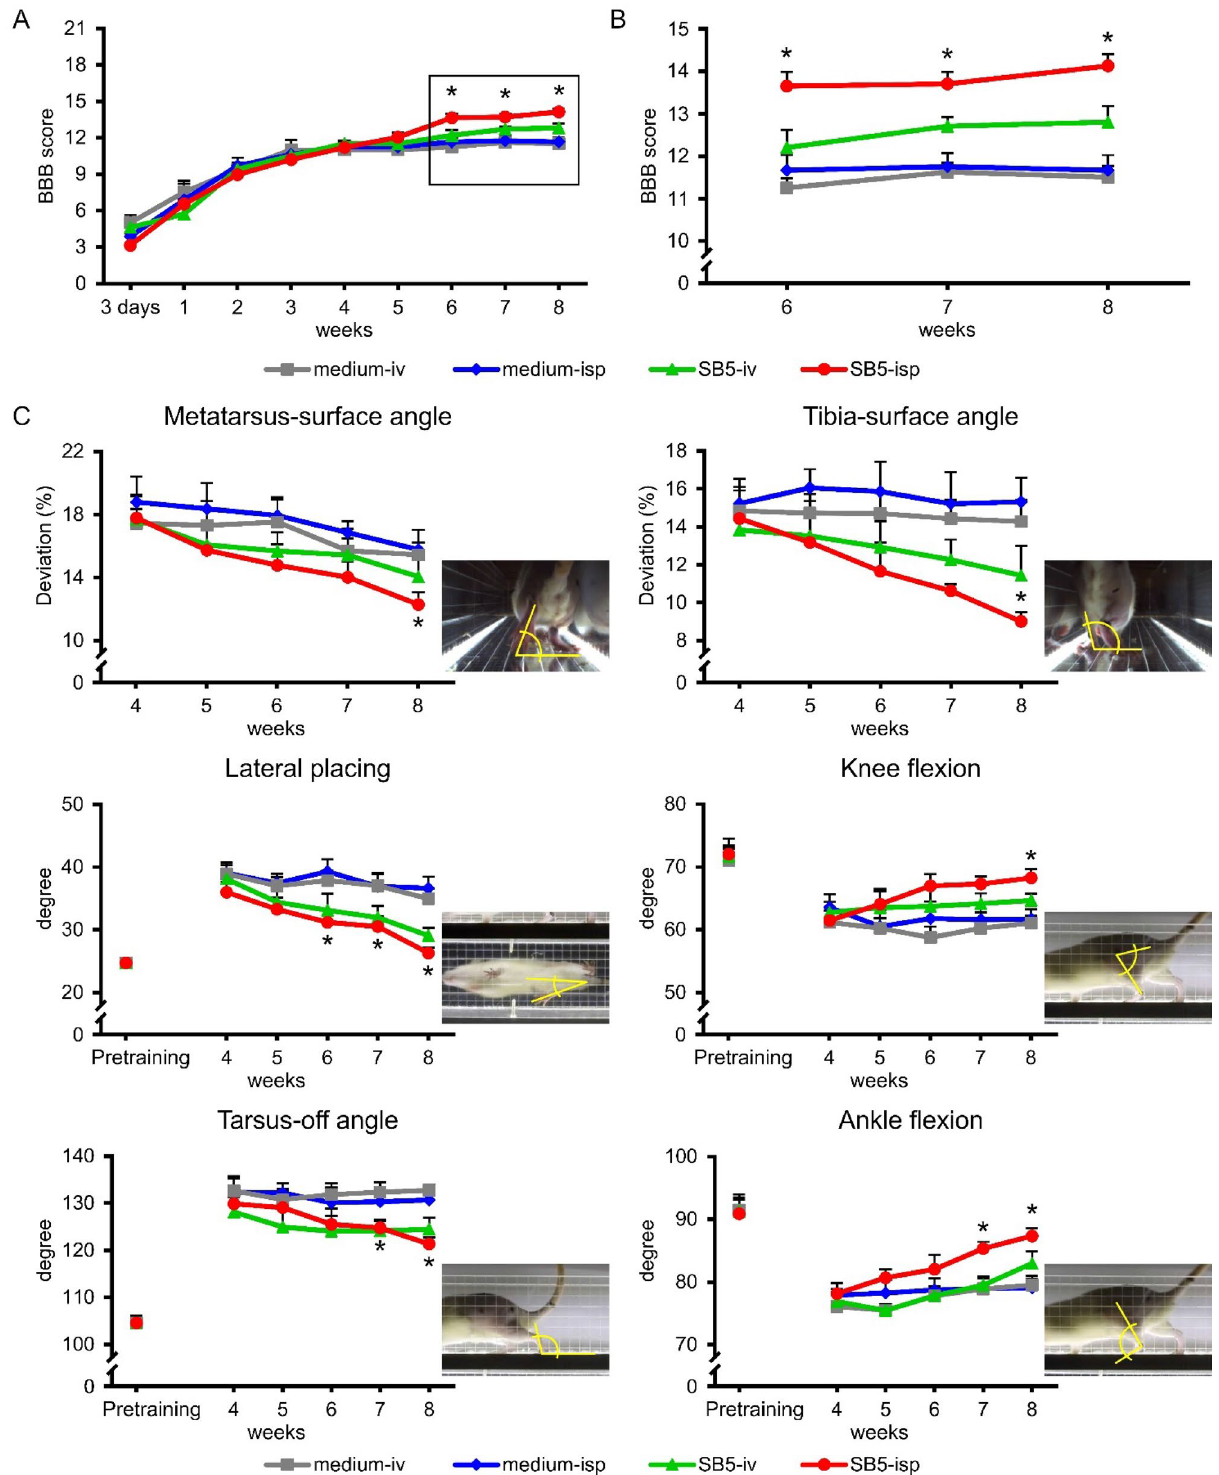
Figure 1. Intraspinal hiPSC transplant improves locomotor function. ( A ) Open field locomotor test (BBB) shows significant improvement of intraspinally grafted animals ( SB5-isp ) compared with their controls, although the SB5-iv animals showed no significant recovery of their locomotor pattern from week 6 onwards. ( B ) Enlarged view of the graphs in A from week 6 onwards. Asterisks represent significant difference between intraspinally grafted ( SB5-isp ) group and its control group at various time points. ( C ) Kinematic analysis of the animals in the various groups after injury. Note the significantly improved parameters of the grafted animals ( SB5-isp ) compared with their controls. Data are expressed as mean ± SEM (n = 8 in each group) *significant difference between the intraspinally grafted animals ( SB5-isp ) and its control ( medium-isp ). p values: BBB-test ( p = 0.012 at week 6, p = 0.022 at week 7, p = 0.016 at week 8), metatarsus-surface angle ( p = 0.048 at week 8), tibia-surface angle ( p = 0.046 at week 8), lateral placing ( p = 0.047 at week 6, p = 0.049 at week 7, p = 0.002 at week 8), knee flexion ( p = 0.048 at week 8), tarsus-off angle ( p = 0.005 at week 8), ankle flexion ( p = 0.036 at week 7, p = 0.003 at week